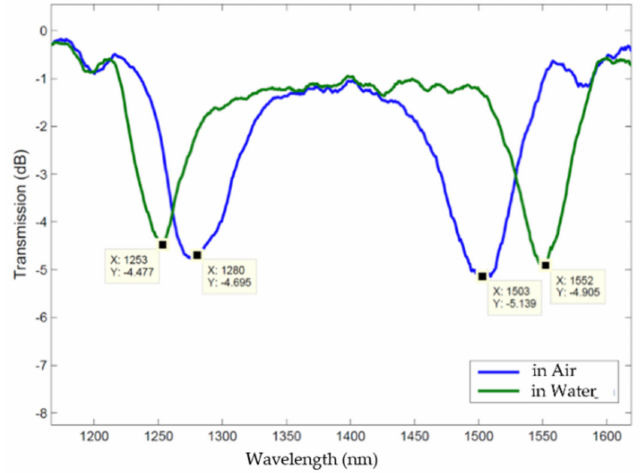
Figure 7. A 148 µ m-LPFG in the DTP, arc-induced in a B/Ge co-doped fiber, immersed in